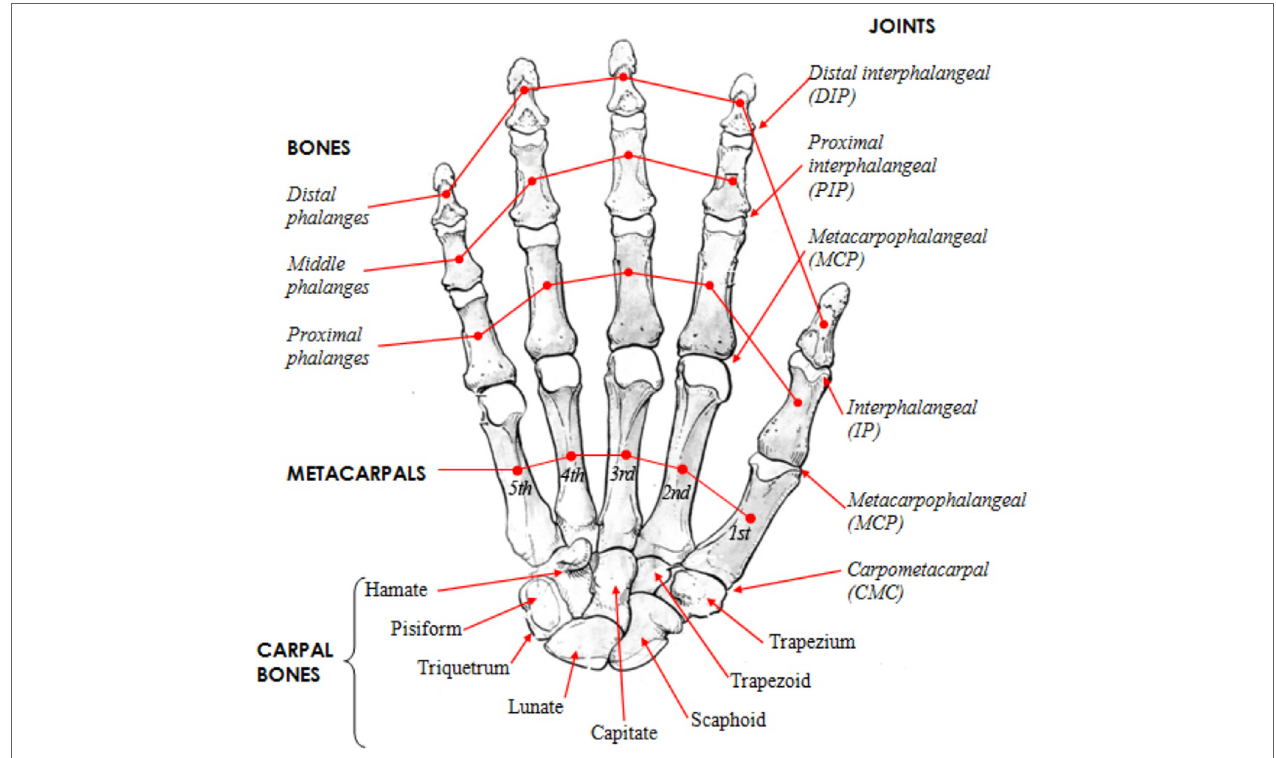
FiGURe 5 | Human hand skeletal structure depicting finger bones, joints, metacarpals, and carpal bones [http://www.amulyabharat.com/hand-bone-anatomy- human-diagram-download/ (Last accessed: